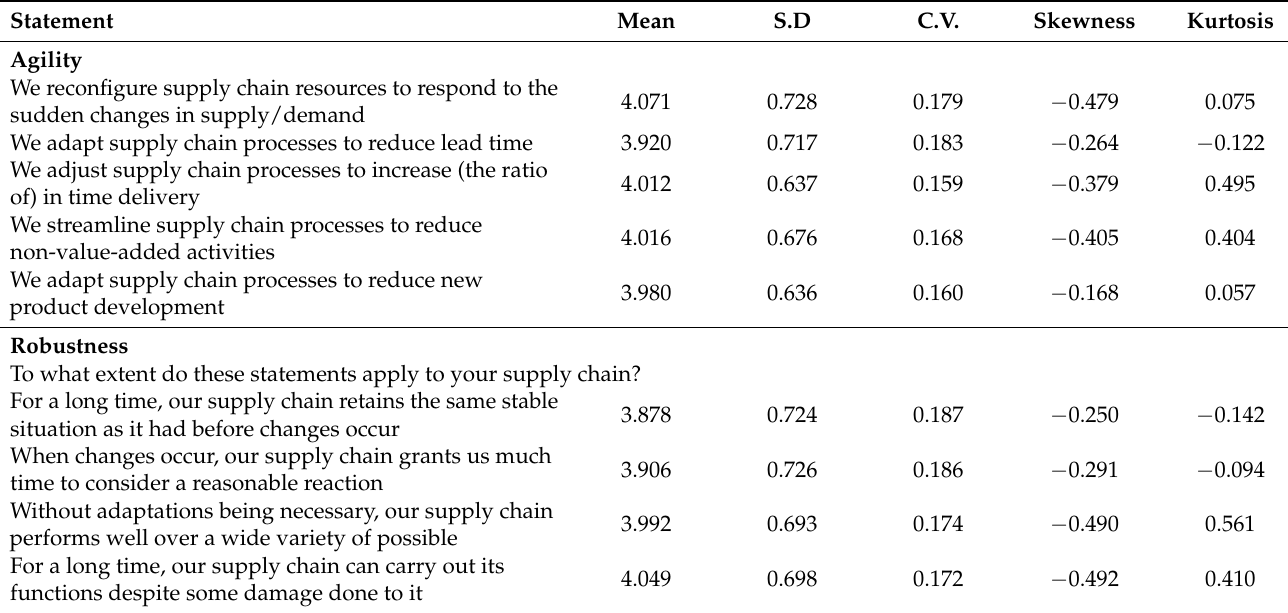
Table 2. Descriptive